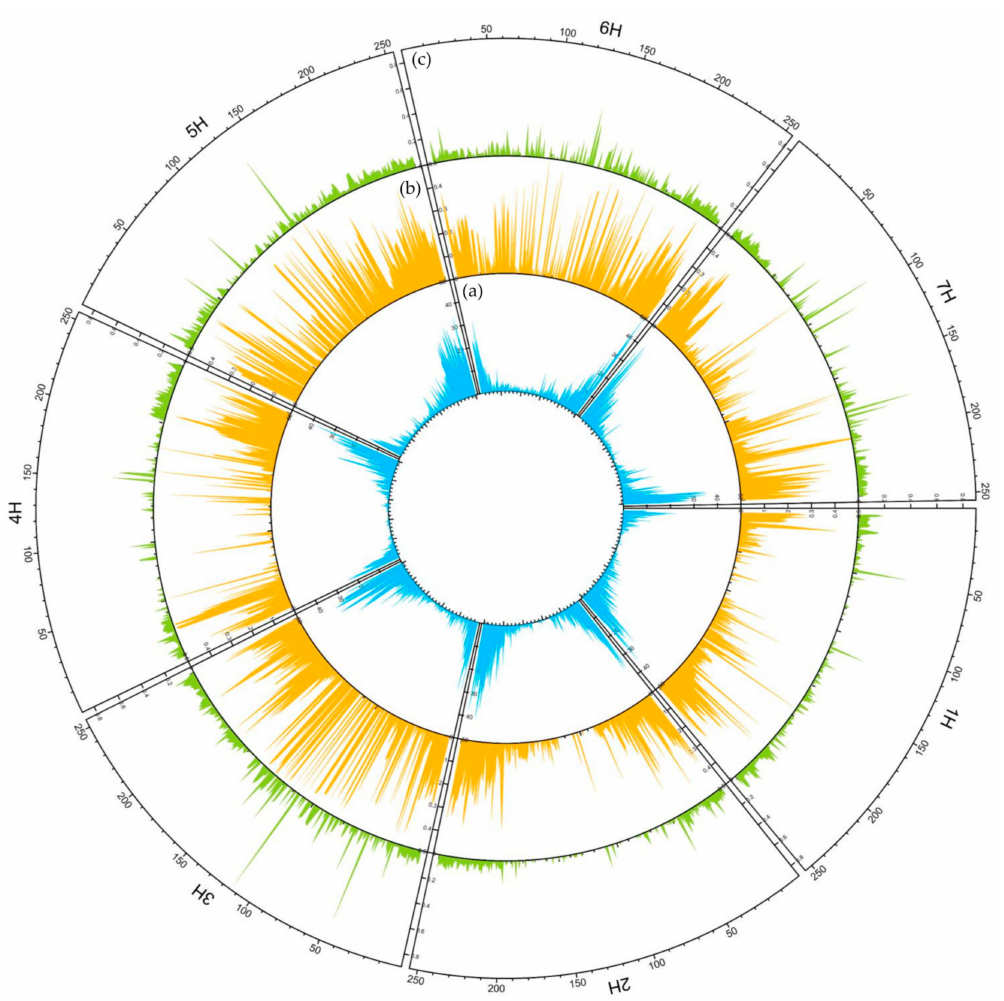
Figure 1. Circular overview of seven H. vulgare chromosomes based on DArTseq data acquired for 83 spring cultivars. ( a ) DArTseq loci distribution; ( b ) Average polymorphism information content (PIC) distribution; ( c ) Average observed heterozygosity (Ho) distribution. A sliding window approach with 500 kb windows, printed for 250 positions along the full length of barley chromosomes based on the genome assembly: IBSC_v2 [21] was